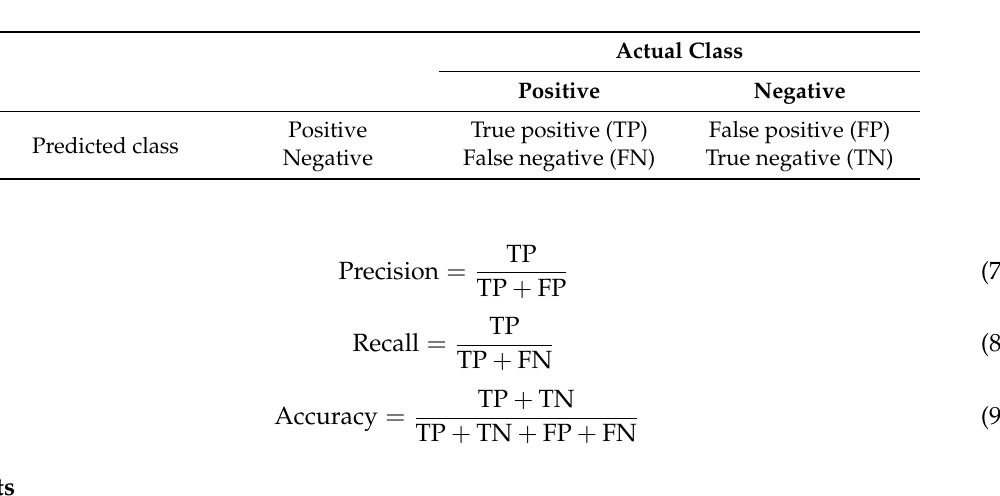
Table 3. Confusion